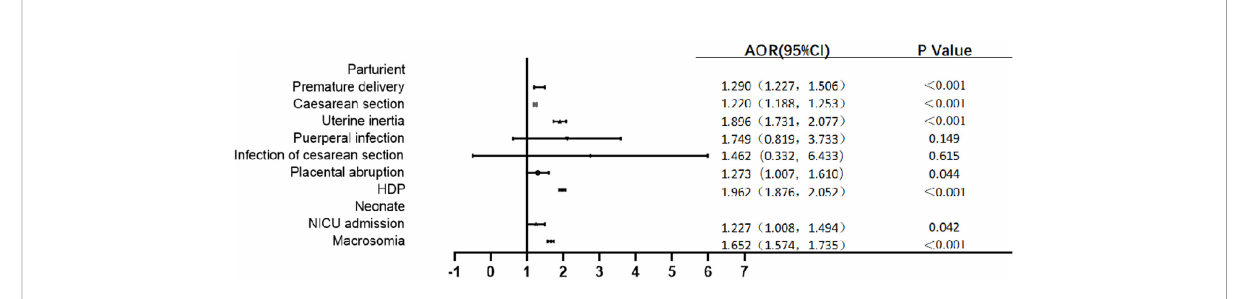
FIGURE 3 Multivariate logistic regression analysis model of maternal and infant outcomes of GDM individuals. HDP: hypertension during pregnancy.Adjusted confounding factors include age, gravidity, parity, education level, gestation-induced hypertension and